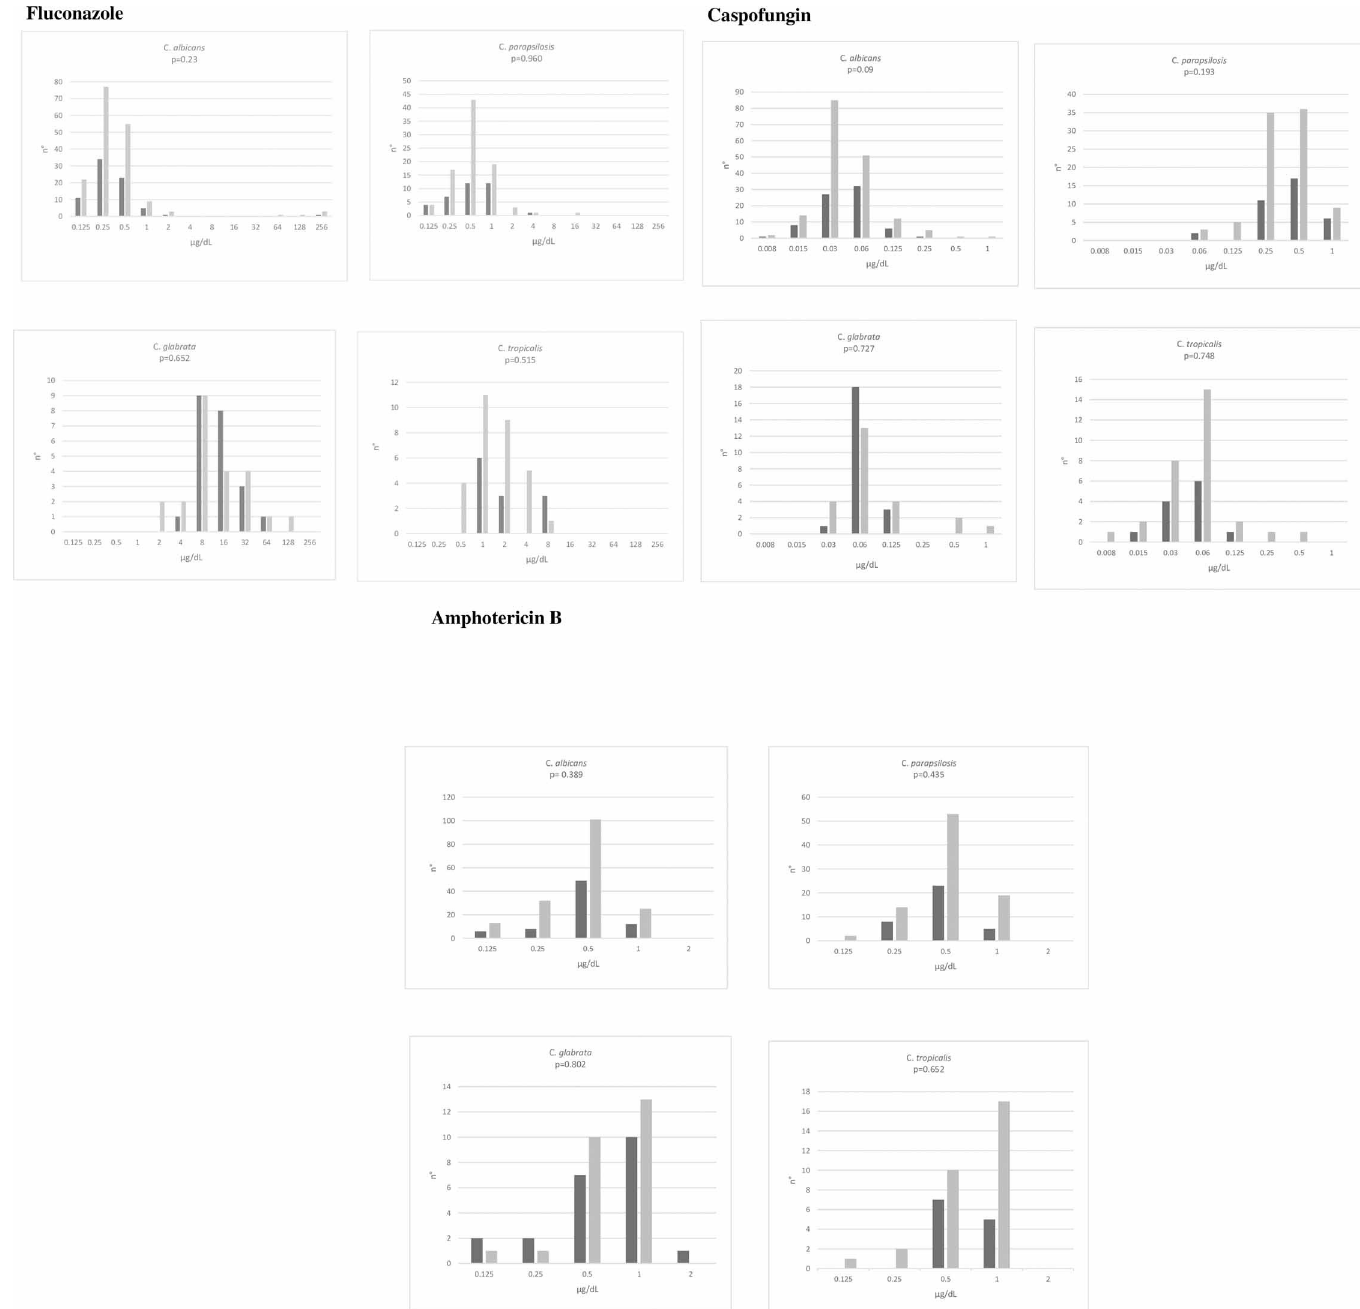
Fig 3. Fluconazole, caspofungin and amphotericin-B MIC distribution for strains of Candida spp. isolated from ICU (black bars) and non-ICU patients (grey bars).